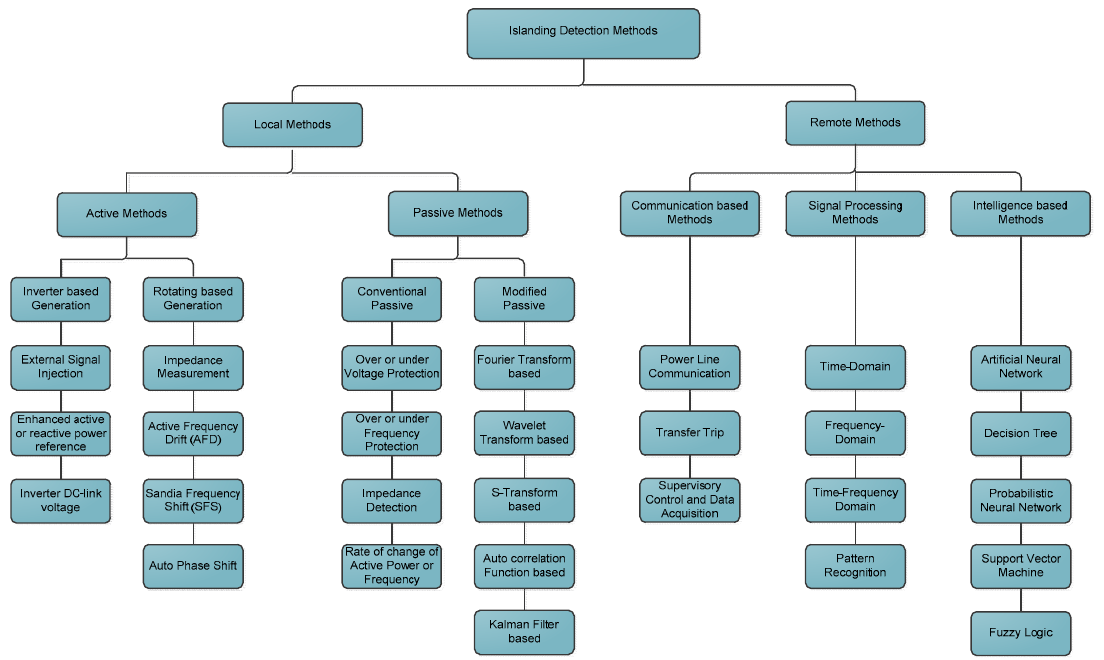
Figure 20. Classification of islanding detection methods.